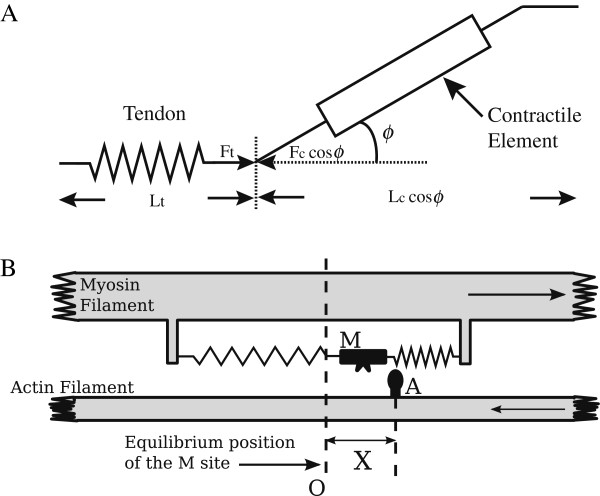
Muscle models. (A) Muscle-tendon macroscopic model. (B) Huxley sliding filaments model.